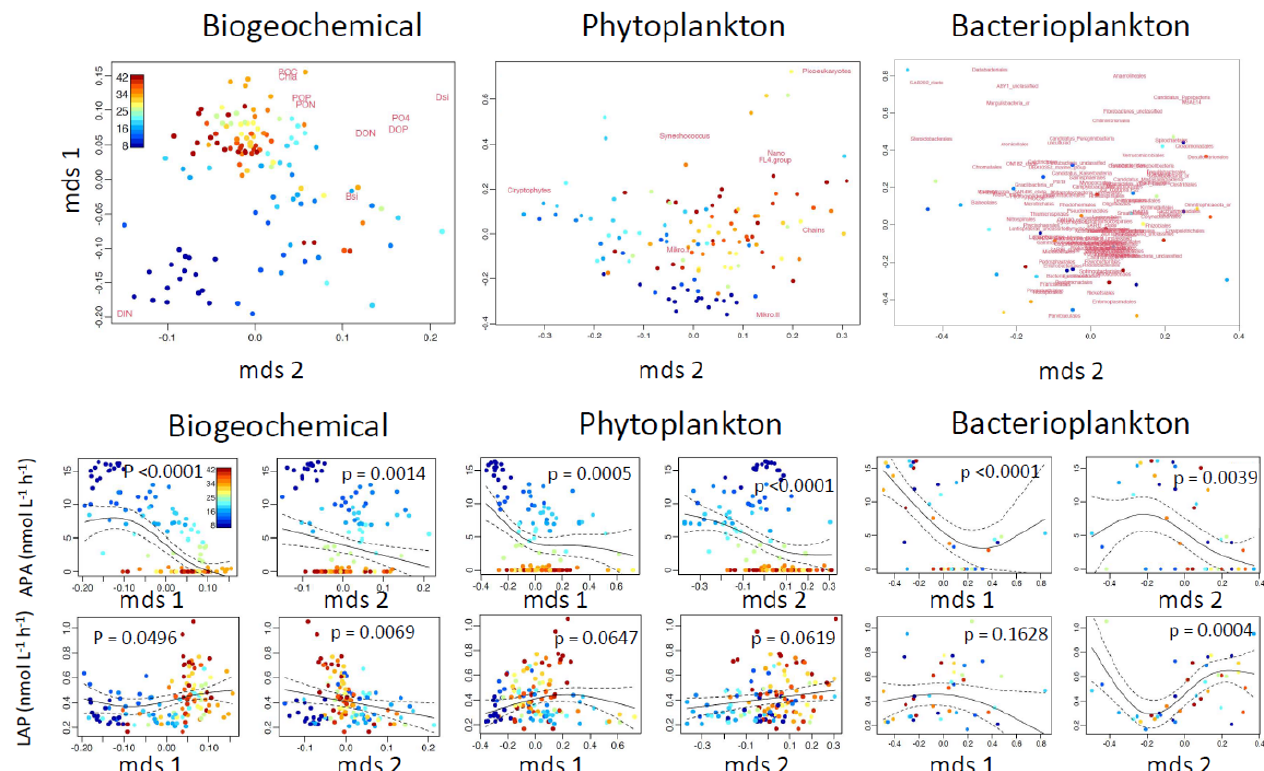
Figure 8. Nonparametric multidimensional scaling (NMDS) plots for the biochemical variables and phytoplankton and bacterioplankton communities (upper row). From the NMDS scores, generalized additive models (GAMs) were made (lower two rows); for these models, we used alkaline phosphatase activity (APA) and leucine aminopeptidase (LAP) as the dependent variables. The output scores (mds1 and mds2) of the NMDS are depicted in the lower two